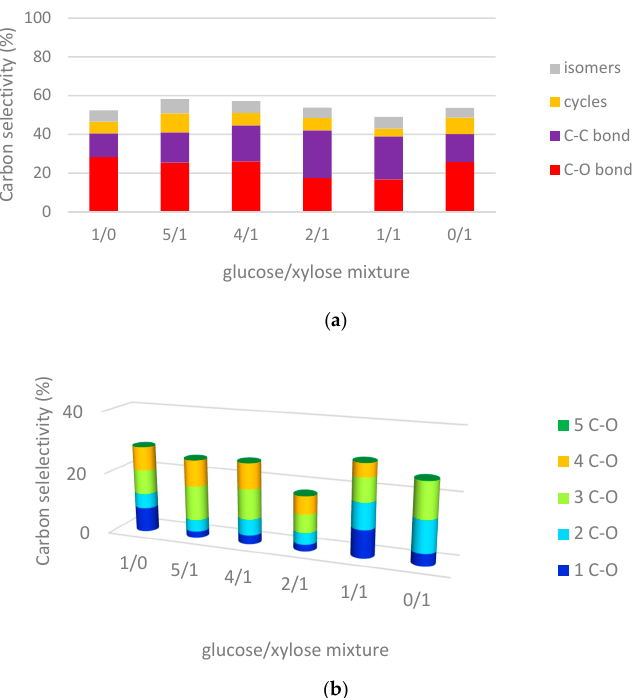
Figure 6. Evolution of carbon selectivity: ( a ) to the different families of products and ( b ) to the sub-families of C-O bond breakage products during hydrogenolysis of sugar mixtures over ReO x -Rh/ZrO 2 , 200 °C under 80 bar H 2 , n substrate /n Rh ~ 200–300, 20% of the sugars remaining as polyols.